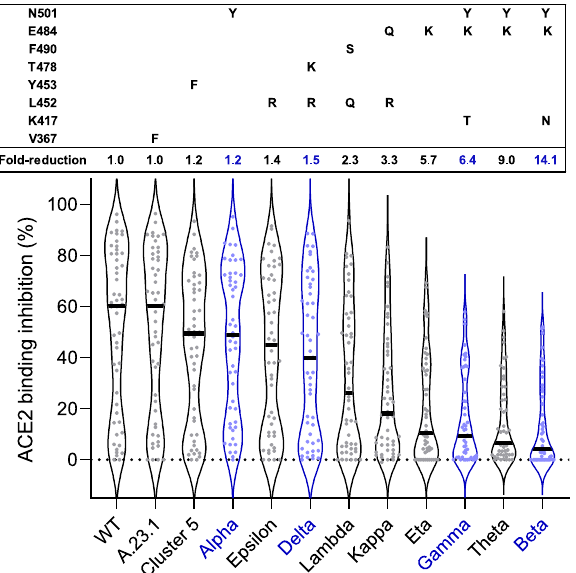
Figure 3. ACE2 binding inhibition varies between RBD mutants. Violin plots showing ACE2 binding inhibition (%) of individual serum samples from 7 to 49 days post PCR (n = 50, depicted as dots) against RBD mutants. Black horizontal lines represent medians. Fold-reduction of ACE2 binding inhibition in comparison to wild-type corresponds to the ratio between the medians of wild-type and the respective RBD mutant. VOC- RBDs are shown in blue. Mutations of each RBD mutant are shown in the box above the violin